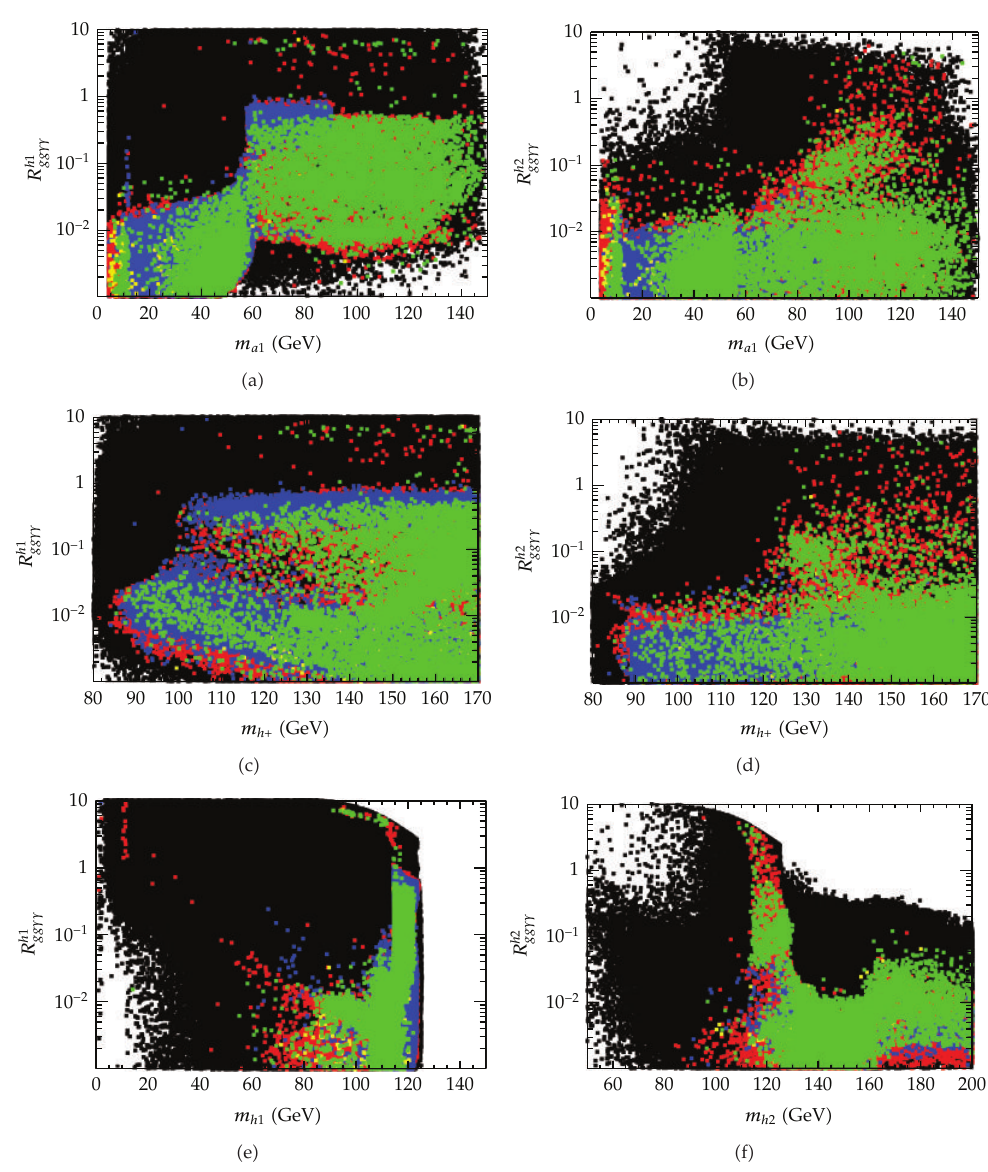
Figure 10: The signal for h 1 → γγ (cid:2) left (cid:3) and h 2 → γγ (cid:2) right (cid:3) relative to the standard model when scanning over the parameters in the scenario under consideration (cid:2) see text for details (cid:3) with the various constraints applied. The colour coding is the same as in Figure